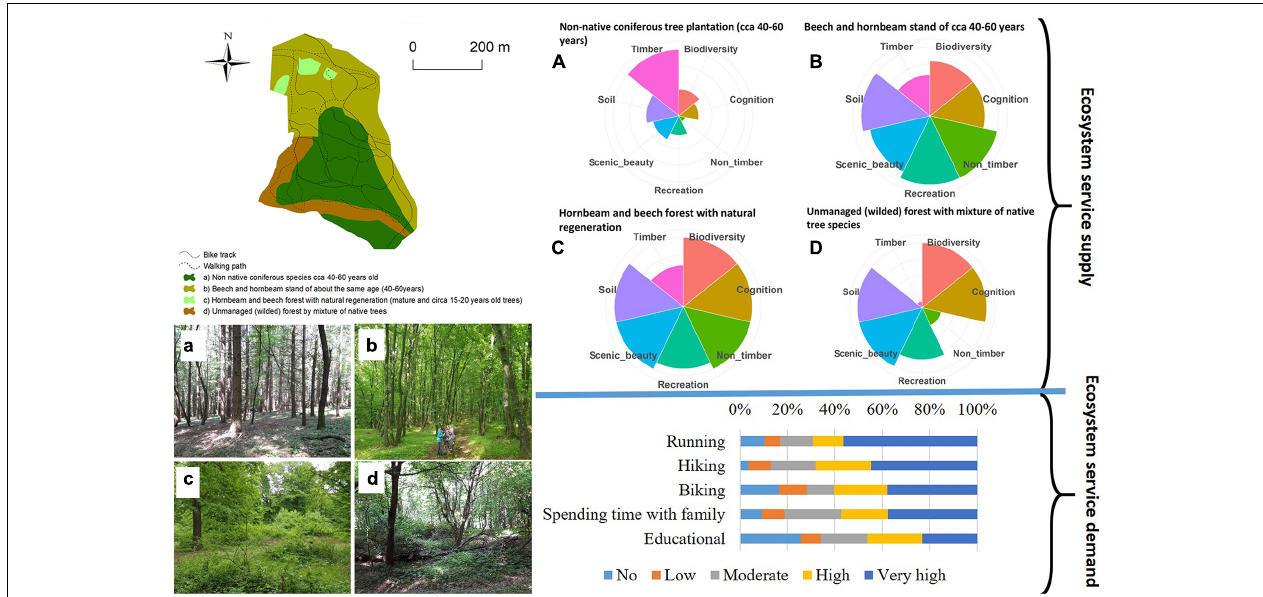
FIGURE 2 | Ecosystem service supply and demand for the focal peri-urban forest area. Up left: a map of the four different forest vegetation structures. Down left: representative pictures, showing the physiognomy of the four different forest vegetation structures (coniferous tree plantation, beech and hornbeam stand, beech and hornbeam with natural regeneration, and unmanaged forests). Right: ecosystem service supply and demand for the four types of the forest areas.